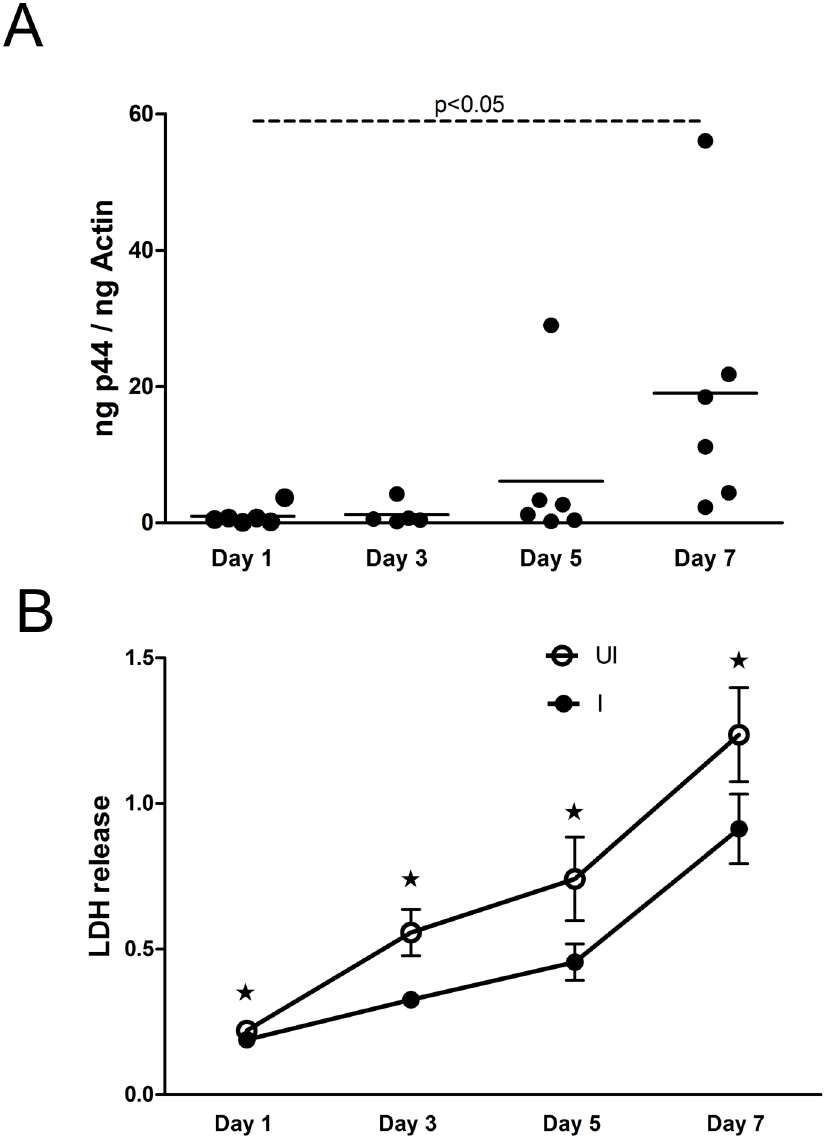
Fig 1. A . phagocytophilum infection decreasescytotoxicity in MEG-01 cells. ( A) QRT-PCR analysis showing A . phagocytophilum burdenin infected-MEG-01 cells at different days (1, 3, 5, 7) p.i. Each circle represents individualexperimental sample. A . phagocytophilum specific p44 DNA levels were normalized to humanbeta-actin levels. (B) LDH assay results performed with cell culture supernatantscollectedfrom uninfected(UI) or A . phagocytophilum -infected (I) at different days (1, 3, 5, 7) p.i. is shown. Valueson the Y- axis show the absorbance for LDH release in the cell culture supernatants. The results for day 1 and day 7 are from three independentexperiments and day 2 and 5 are from two independentexperiments performed in triplicates. All cultures were started simultaneously at the same time. The culture medium was not changed daily. The P value (P < 0.05)calculatedfrom Student’st test was considered significant.Asterisk abovethe error bar indicates statistically significantdifference betweenUI and I samples from the same time point. uninfected controls. However, at late stage of infection (day 7 p.i.), mRNA levels for all tested cell cycle genes were significantly (P < 0.05) down regulated in A . phagocytophilum -infected cells in comparison to the uninfected MEG-01 cells (Fig 2A–2F). The evaluation of beta-actin transcripts normalized to total RNA concentrations revealed no significant (P > 0.05)